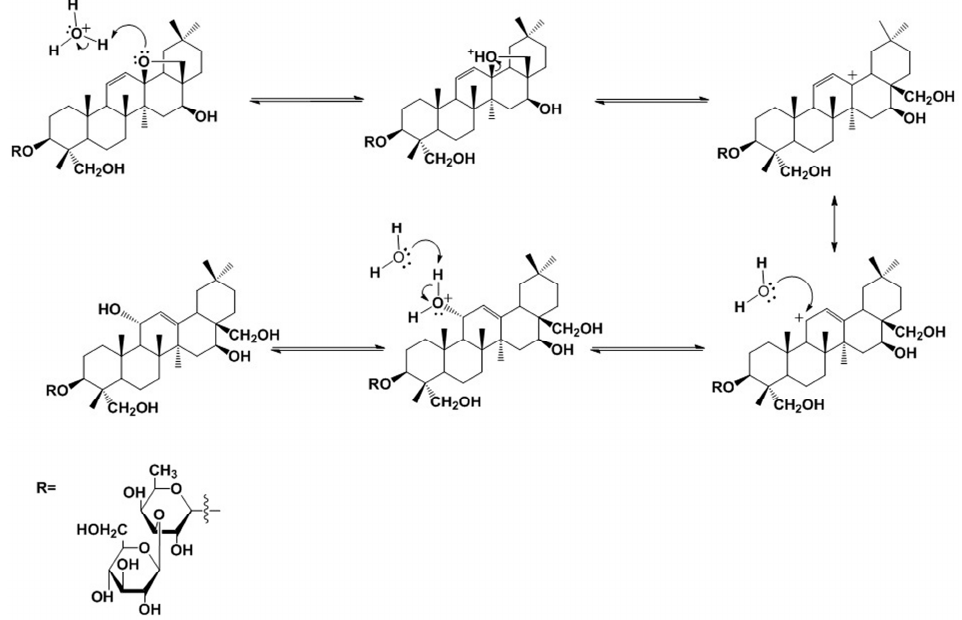
Figure 4. Proposed structural transformation pathway of hydroxy-saikosaponin A.